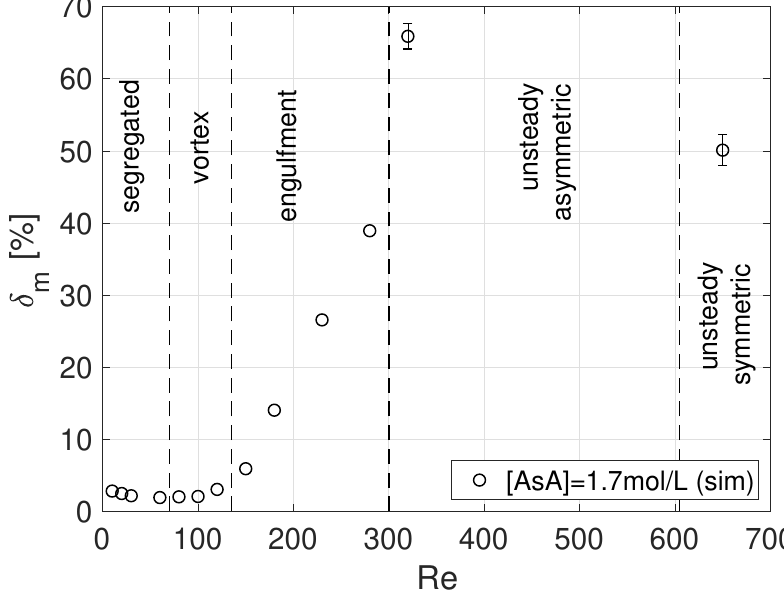
Figure 6. Mixing degree at Y = − 25 as a function of Reynolds number for steady and un- steady